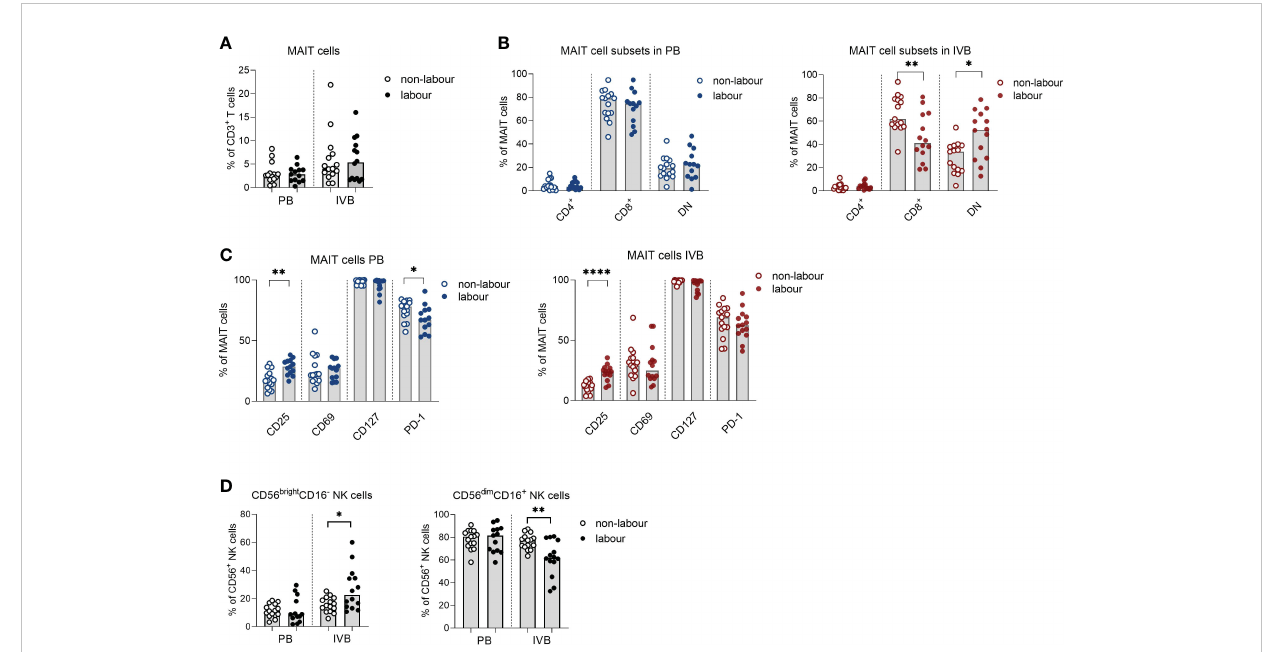
FIGURE 5 Innate-like lymphocytes are affected by labour. (A) Proportions of mucosal-associated invariant T (MAIT) cells out of CD3 + T cells in labour or non- labour peripheral blood (PB) and intervillous blood (IVB). (B) Proportions of CD4 + , CD8 + and double negative (DN) MAIT cells in PB and IVB from women without labour or with labour. (C) Proportions of MAIT cells in PB and IVB expressing the activation markers CD25, CD69, CD127 and PD-1 in women delivering with labour or without labour. (D) Proportion of CD56 bright CD16 - and CD56 dim CD16 + NK cells out of the CD56 + population in PB and IVB from women delivering with labour or without labour. Data is presented as median and statistical differences were determined with Mann Whitney test, *p<0.05, **p<0.01,